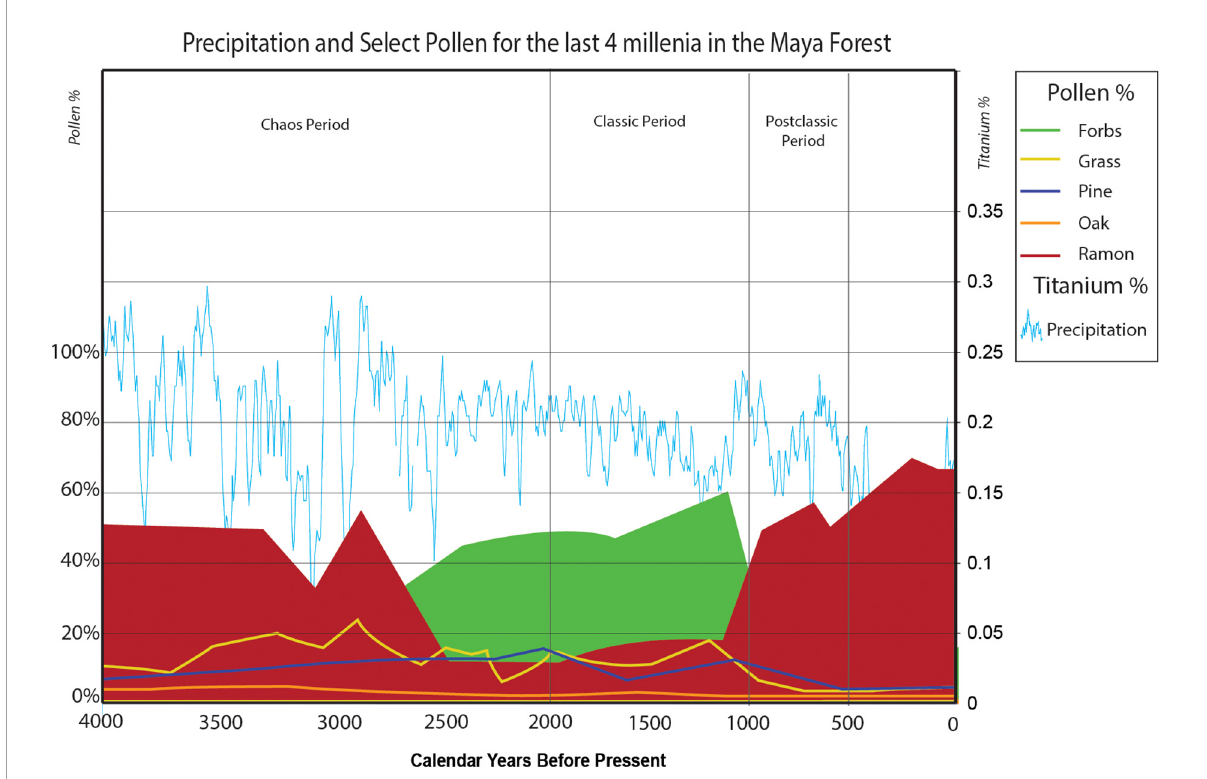
FIGURE4 Precipitation proxy and key pollen for the last four millennia in the Maya forest. Scaled pollen data from Curtis et al. (1998), Brenner et al. (2002), and Leyden (2002) with Moracea-type, Brosimum alicastrum /Ramon as the indicator of forest, and the Cariaco Ti precipitation proxy data from Haug et al. (2003). Compiled by ISBER/MesoAmerican Research Center,